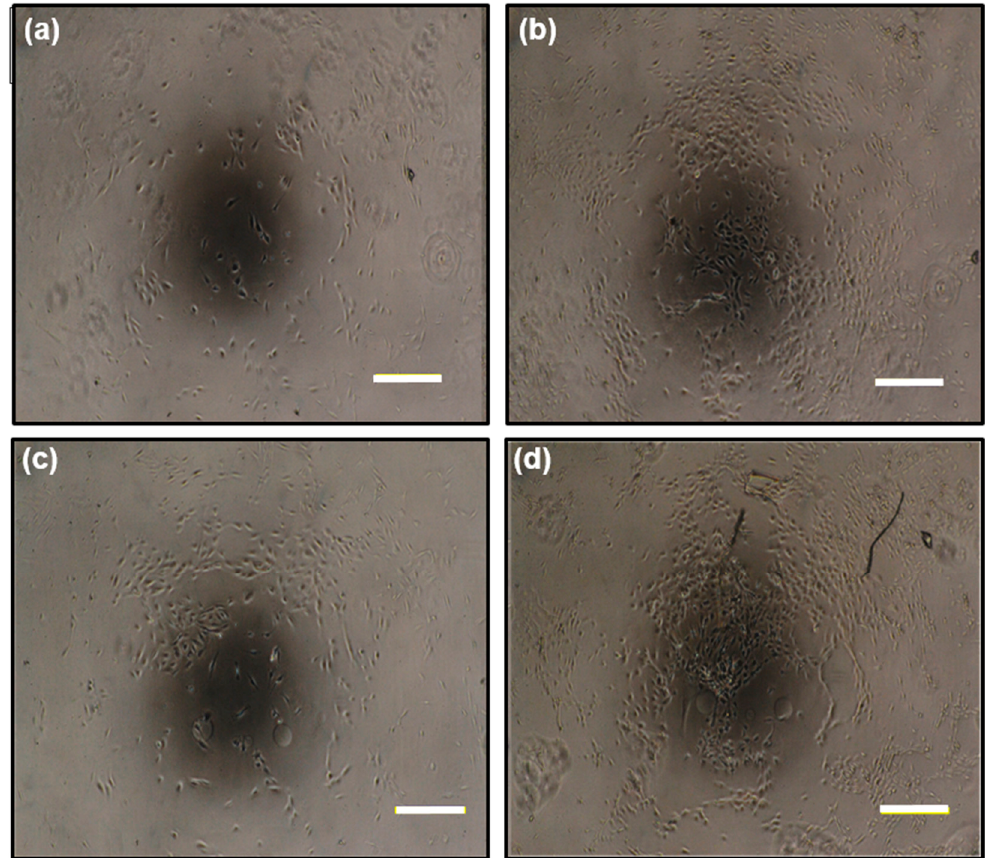
Figure 6. Cell photographs of the human umbilical vein endothelial cell (HUVEC) culture on gelatin gels: 1 day after seeding with ( a ) an ABA-free gelatin gel and ( b ) an ABA-immobilized gelatin gel; 4 days after seeding with ( c ) an ABA-free gelatin gel and ( d ) an ABA-immobilized gelatin gel. The bars represent 200 µm.